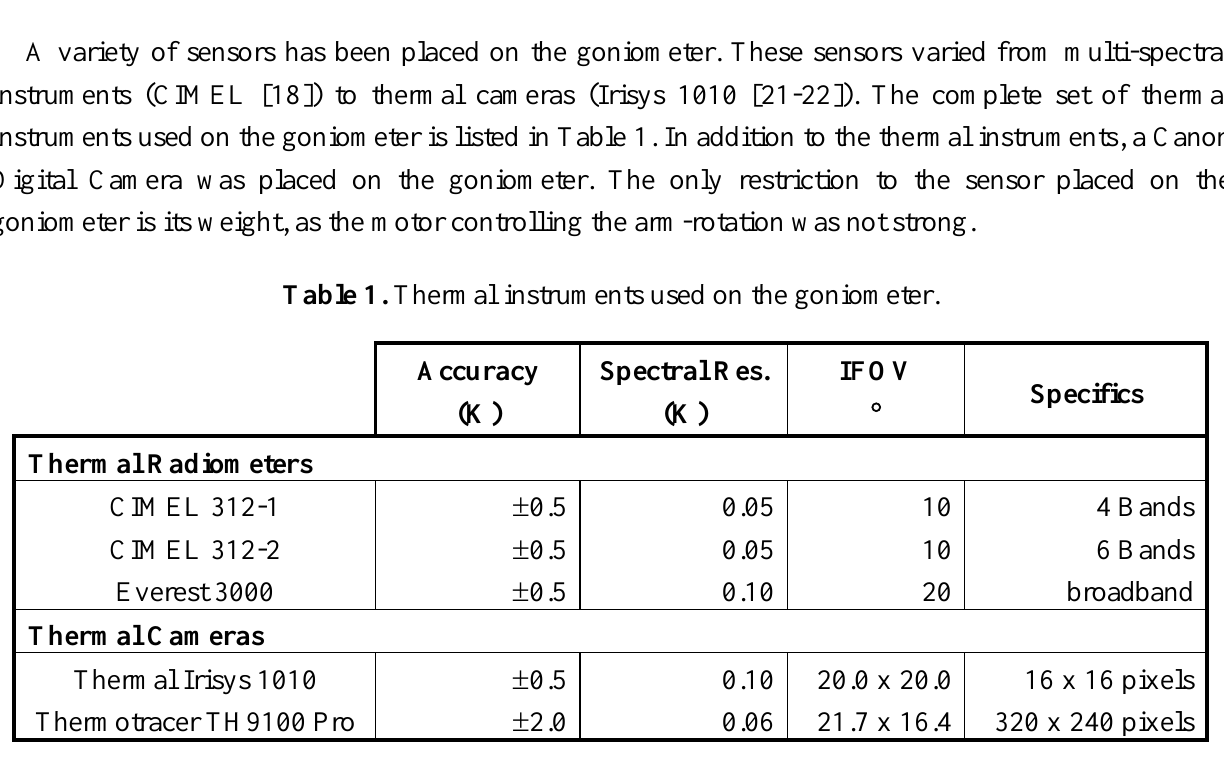
Table 2. Supplemental instruments used during the directional acquisition of thermal